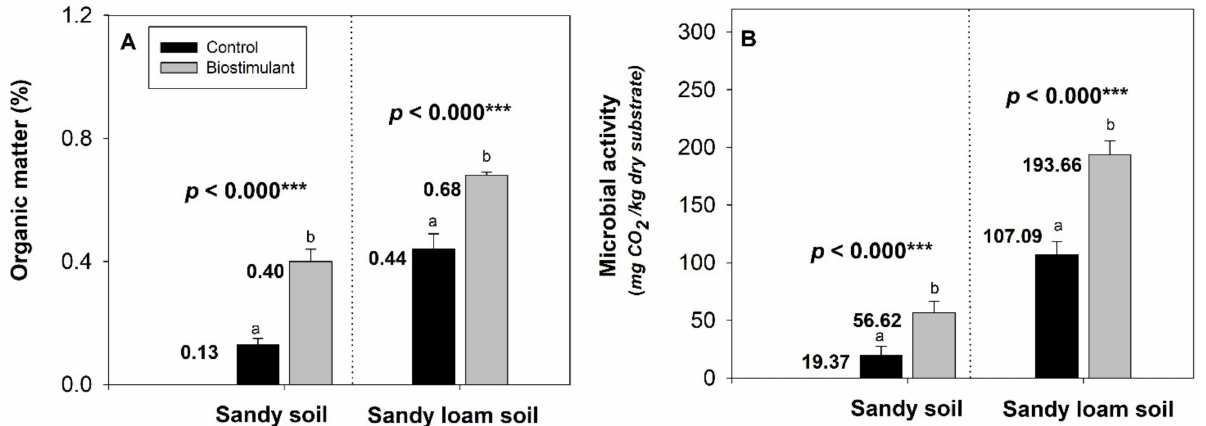
Figure 1. Mean values of soil organic matter ( A ) and microbial activity ( B ) of soil samples treated by biostimulant and control of about the two types of soil. Means followed by different letters are significantly different ( p < 0.05) according to Tukey’s HSD test. Significance levels: *** p <